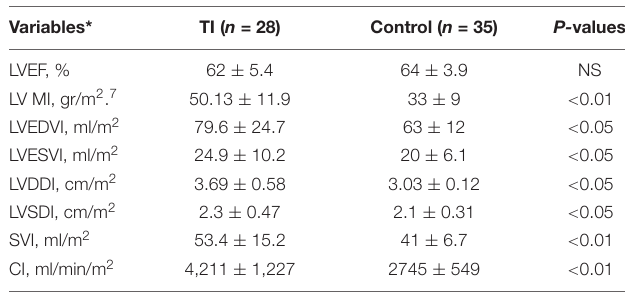
TABLE 2 | Geometry, cardiac volume, and cardiac index in patients and control